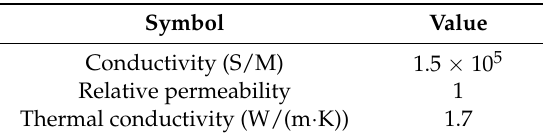
Table 4. Material characteristics of carbon fiber.